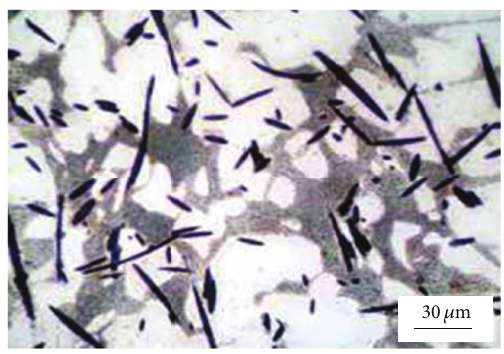
Figure 8: Micrograph representing Mg-8Lif